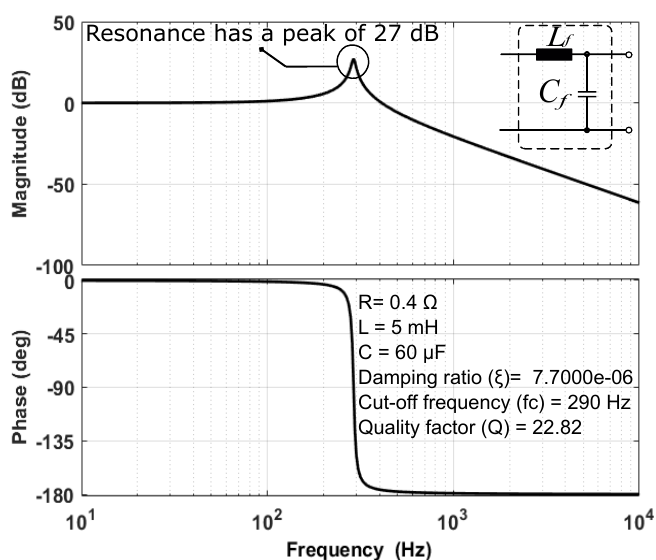
Figure 8. A bode plot shows the frequency response of the LC, which is used in the experimental